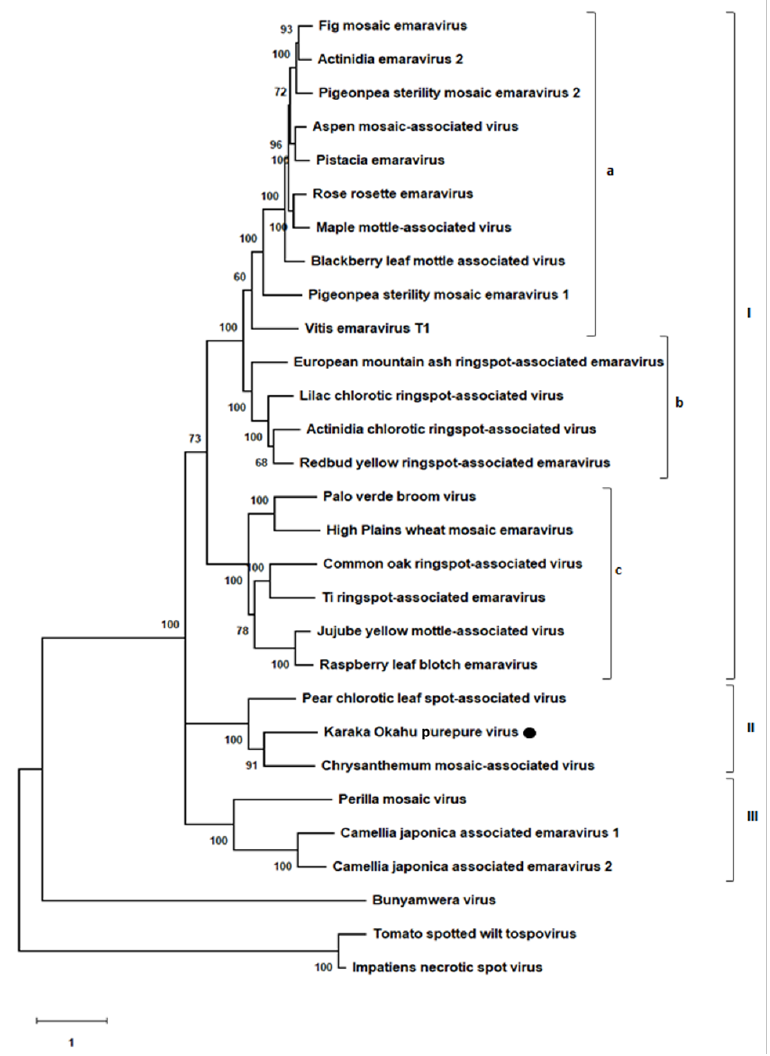
Figure 3. Phylogenetic tree inferred using the amino acid sequences of the putative RdRp. The tree was constructed using the maximum likelihood method with 1000 bootstraps. Sequences used in this analysis are listed in Supplementary Table S1. Boostrap values are indicated at the nodes. The scale bar represents the number of amino acid substitutions per site. The three major clades are I, II and III, with the largest clade (clade I) split into three subclades (subclades a, b and c).